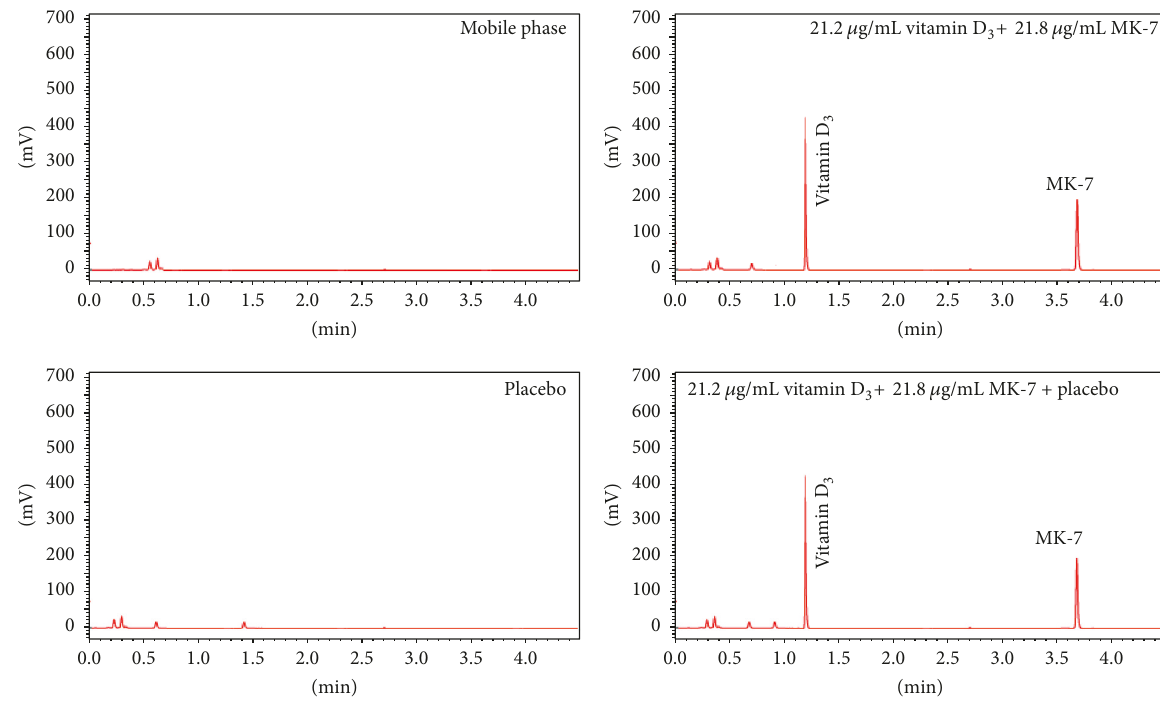
Figure 3: Typical UHPLC chromatograms of vitamin D 3 and MK-7 with and without placebo. Table 2: System suitability test